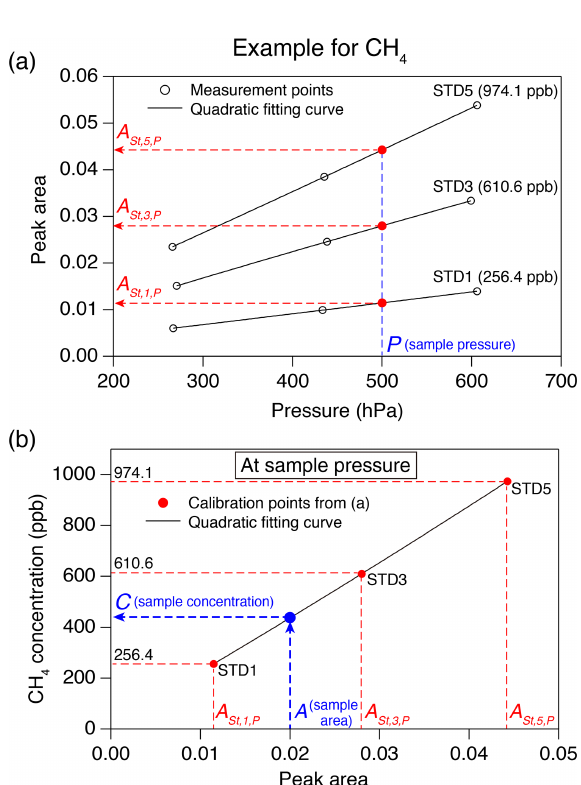
Figure 5. Example of a calibration procedure for greenhouse gas concentration. (a) Peak areas for three standard gases measured at three pressures (black circles), with quadratic fits (black lines). Peak areas of the standard gases ( A St , 1 ,P , A St , 3 ,P , and A St , 5 ,P , red cir- cles) estimated at the sample pressure (blue dashed line) are also shown. (b) Calibration curve at the sample pressure (black line) from the peak areas from panel (a) . The numbers in the panel are CH 4 concentrations of the standard gases, A is the peak area of the sample and C is the CH 4 concentration of the